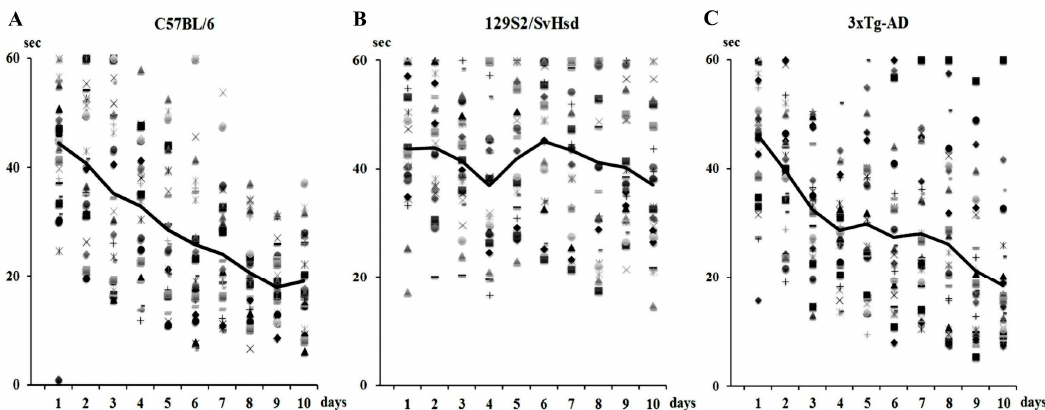
Figure 1. The latency in seconds to find a hidden platform within 60 s over 10 consecutive days of testing is presented for each group: C57BL/6 ( A ); 129S2/SvHsd ( B ); and the triple transgenic mouse model of Alzheimer’s disease (AD) (3xTg-AD) ( C ). Latencies obtained from individual animals are plotted by different marks. Solid black lines show average latencies calculated for each day.